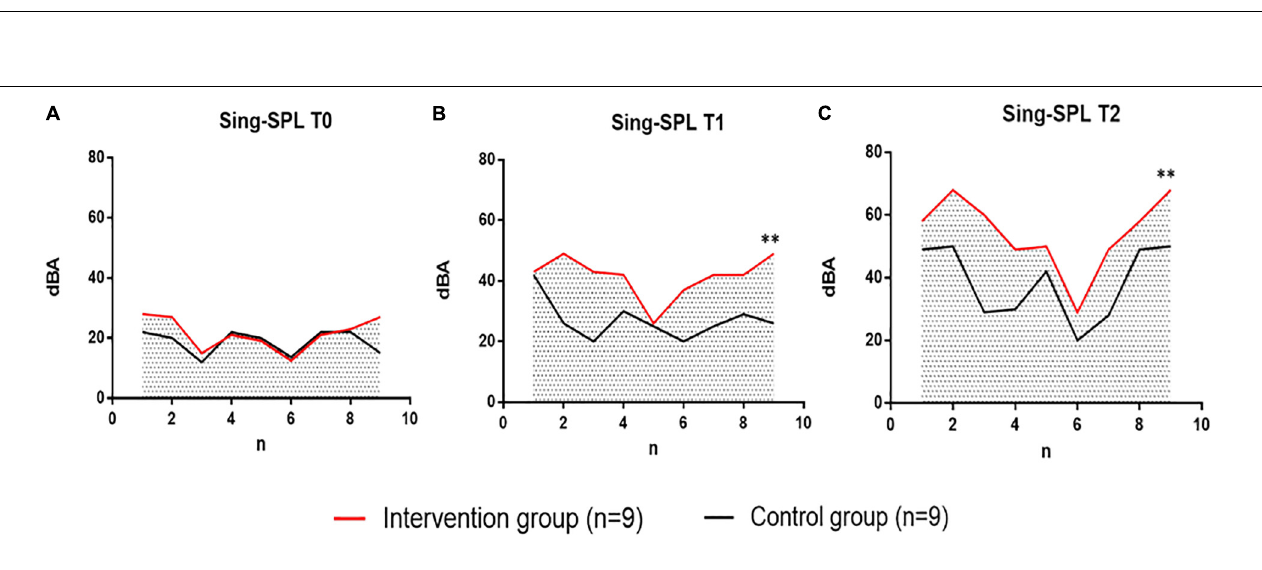
Frontiers in Neuroscience |